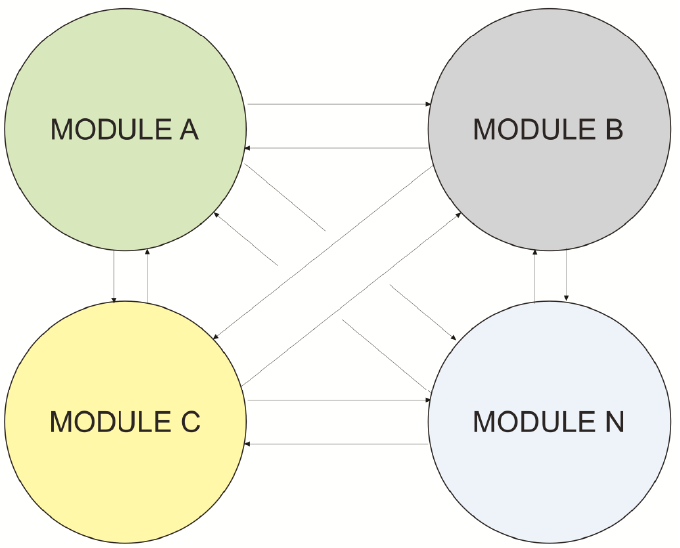
Figure 8. Biomass refinery system in the Modular model. Arrows indicate possible links between modules.